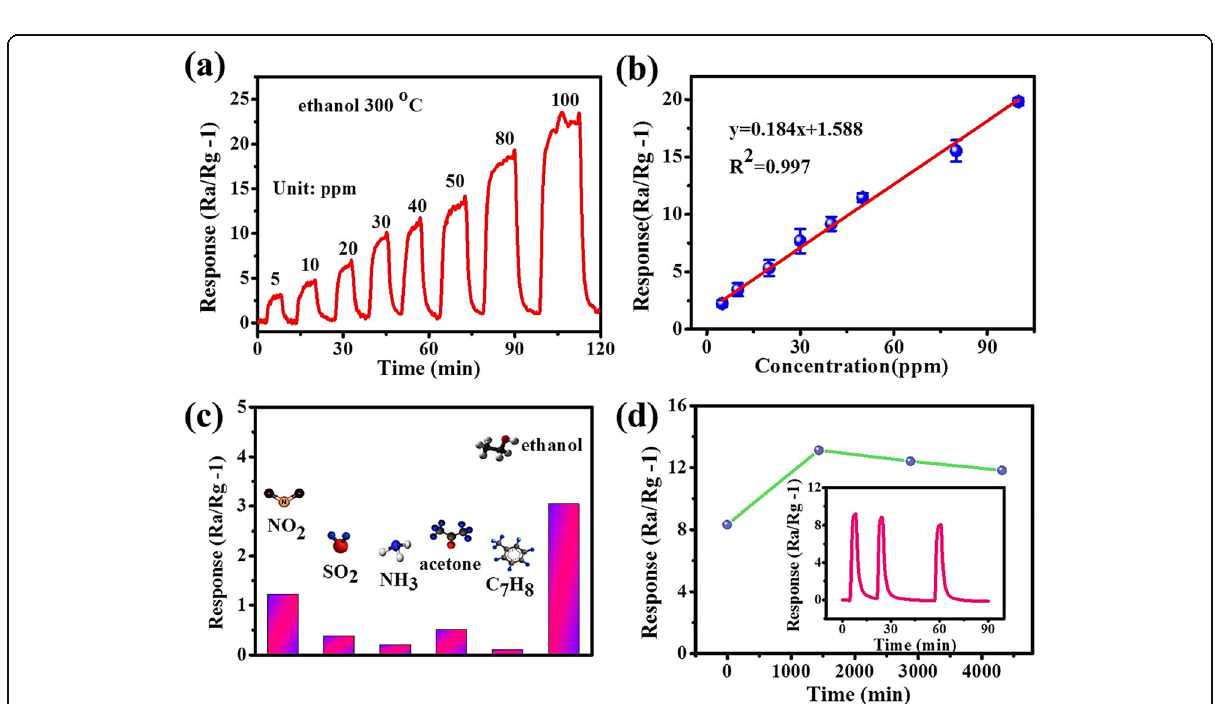
Fig. 7 a Real-time response curve to different ethanol concentrations at 300 °C. b The response linear fitting curve as a function of the ethanol concentration at 300 °C. c Gas responses of cross-linked SnO 2 :NiO network to 5 ppm various target gases including NO 2 , SO 2 , NH 3 , acetone, C 7 H 8 , and ethanol. d The response stability of a typical SnO 2 /NiO network sensor continuously measured in 3 days to 50 ppm ethanol at 300 °C. The inset figure in ( d ) shows the response-recovery curve of the same sensor measured after 3